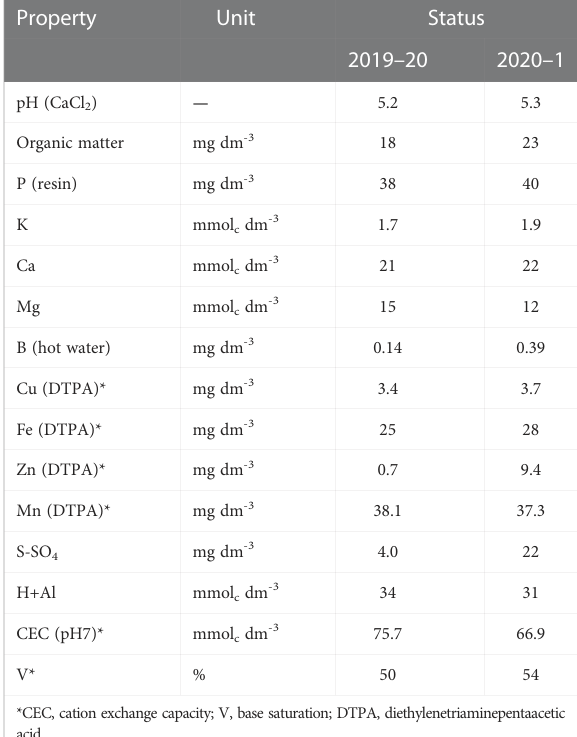
FIGURE 2 Rainfall, maximum and minimum temperatures, and light radiation during the experimental period at a weather station of the Extension and Research Farm of School of Engineering